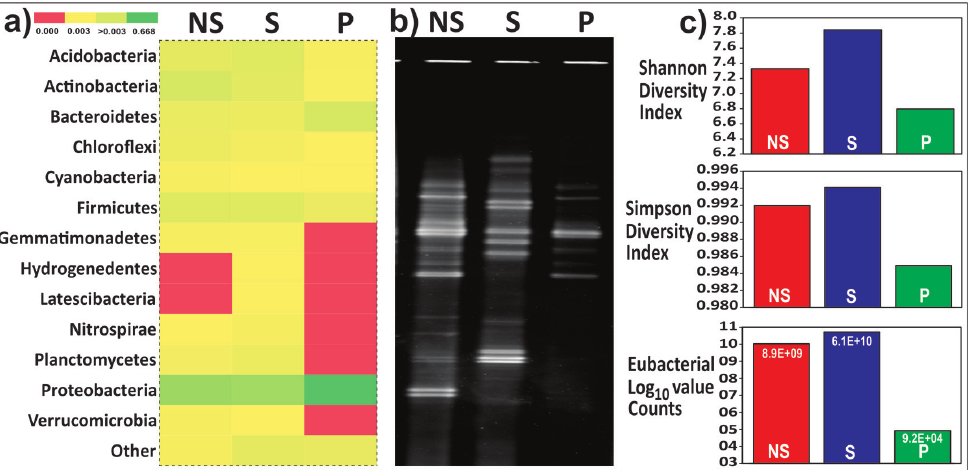
Fig. 1. Comparison of bacterial diversity in root-associated soil (Database used SILVA123) a) Heatmap for phylum- level diversity b) Fingerprint of root-associated microbiome by PCR-DGGE c) Graphical representation of alpha diversity indices and actual eubacteria count by quantitative PCR. Table 1. Eubacterial taxonomic features of root-associated diversity Diversity